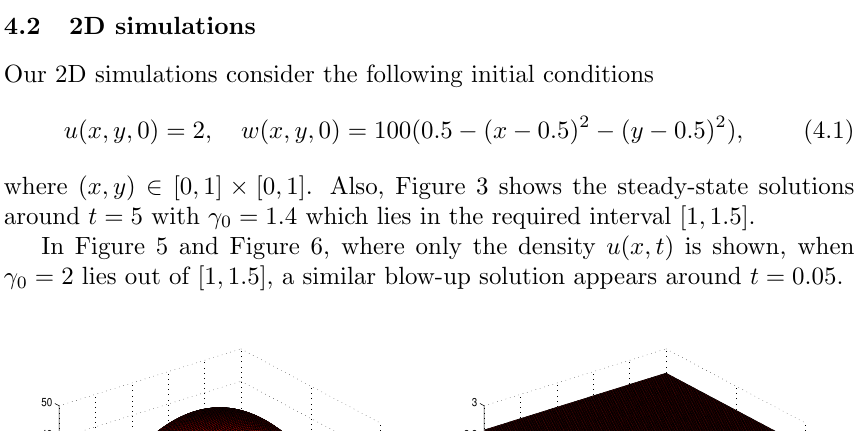
Figure 3. γ 0 = 3, the structure of solutions at t = 0 . 1.